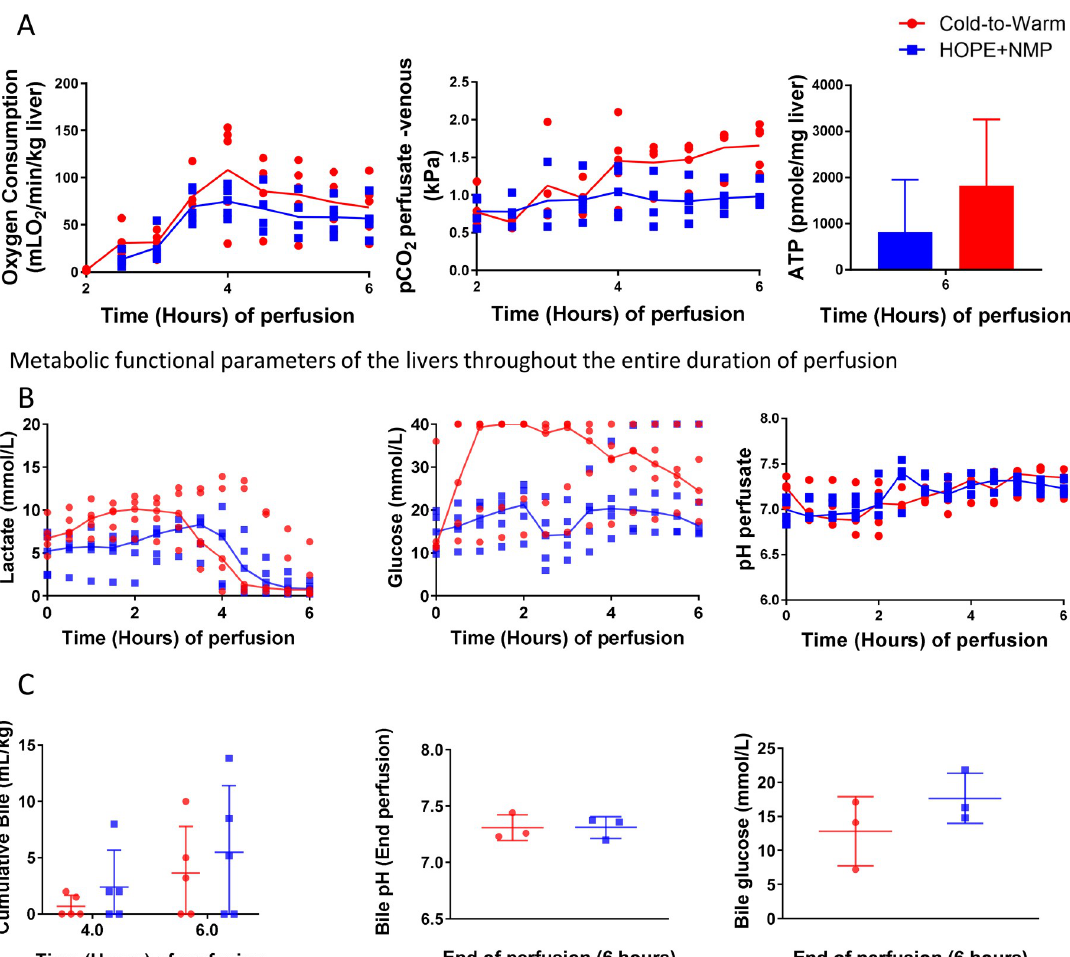
Fig 3. Mitochondrial and hepatic functional markers during the normothermic phase. Panel A shows a similar incremental rate of oxygen consumption during the rewarming period, which finally culminated in a higher peak at the beginning of the normothermic phase for the cold-to-warm group. The rate of carbon dioxide (CO 2 ) release in the perfusate followed a similar trend to the oxygen consumption, and the adenosine triphosphate (ATP) levels reached higher figures at the end of the 6 hours of perfusion in the cold-to- warm group than with the HOPE+NMP. Panel B represents parameters of metabolic function of the organs during the perfusion. During the hypothermic phase, lactate levels increased slightly for the livers that had D-HOPE and were constant throughout HOPE. After rewarming, the lactate peak was comparable between groups, and then the lactate clearance was more effective in the cold-to-warm group resulting in similar levels at the end of the perfusion. There was evidence of glycogenolysis at the beginning of the D-HOPE perfusion, and thereafter the organs start to consume glucose during the NMP phase. For the HOPE+NMP group, there was a sudden drop related to perfusate change at 2-hour perfusion and then the livers start to metabolise glucose during the NMP phase. Perfusate pH was similar between groups during the perfusion. Three livers in each group produced bile during the perfusion (Panel C). The bile pH was comparable between them, as was the glucose content. In the graphs, dots represent individual organs at the time points, and the line is the median of the values for each group. For the bar graph, the median and interquartile range are